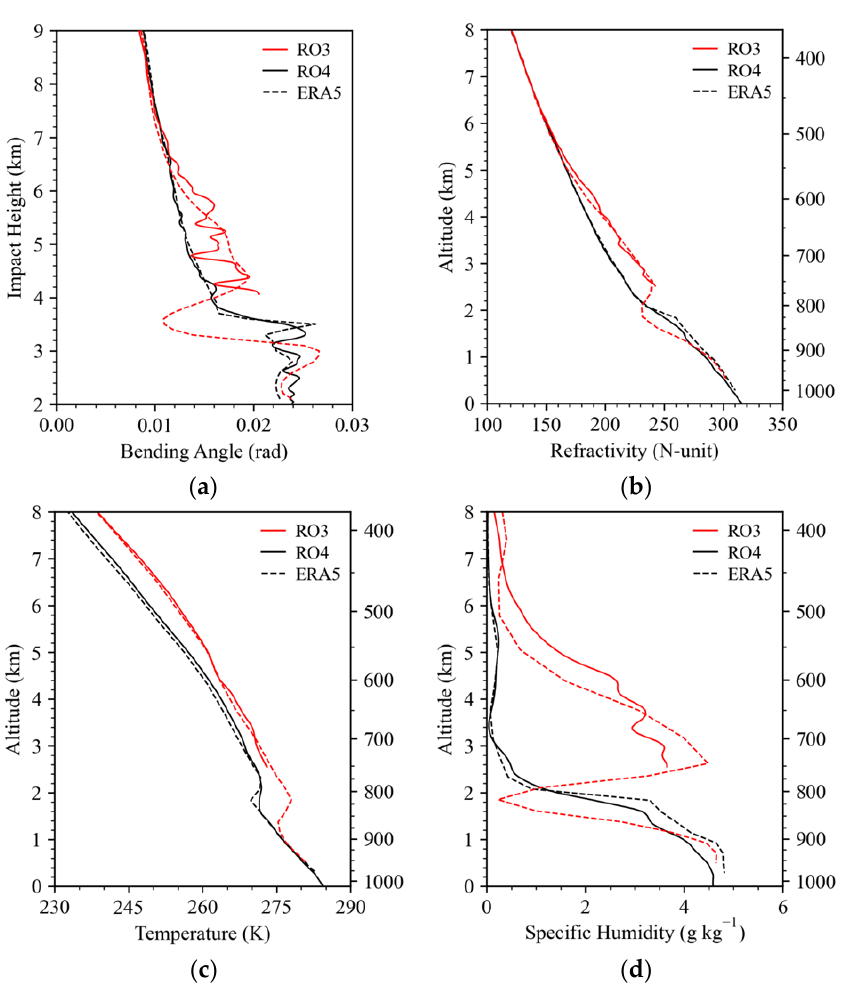
Figure 9. Vertical profiles of ( a ) bending angle, ( b ) refractivity, ( c ) temperature and ( d ) specific humidity from COSMIC-2 RO observation (solid) and ERA5 reanalysis (dashed) for RO3 and RO4, which are located at (37.11 ◦ S, 96.27 ◦ W) and (31.56 ◦ S, 84.29 ◦ W) in the SEP area and observed at 1433 and 1526 UTC 30 August 2020,